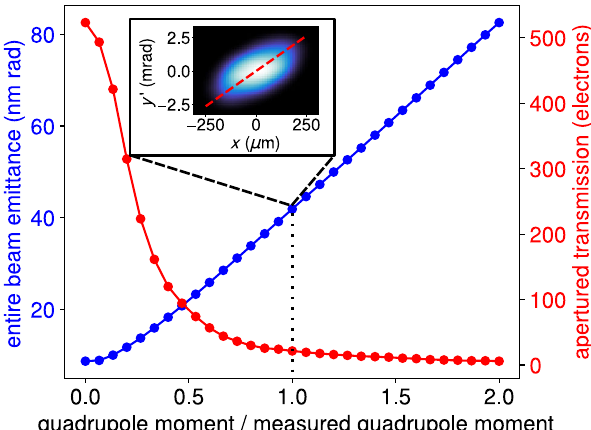
FIG. 4. A simulated example of the effects of the stray quadrupole moments on entire beam emittance (blue) and trans- mission through the final aperture (red). The stray quadrupole moments found by the fits in Fig. 3 were scaled by a global factor, shown on the x axis, to show the dependence on their strengths. Inset: The x - y 0 phase space measured in the experiment. A clear correlation, highlighted by the red dashed line, can be